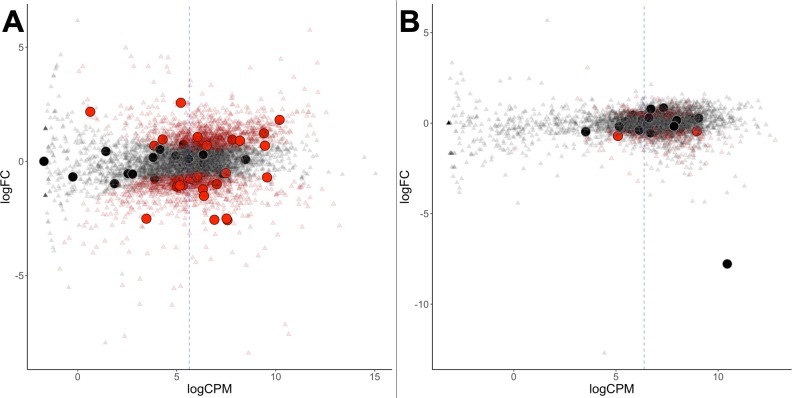
Differential gene expression of G. sulphuraria 074W.(A) and C. merolae 10D (B), here measured as log fold change (logFC) vs transcription rate (logCPM). Differentially expressed genes are colored red (quasi-likelihood (QL) F-test, Benjamini-Hochberg, p <= 0.01). HGT candidates are shown as large circles. The blue dashes indicate the average logCPM of the dataset. Although HGT candidates are not significantly more or less expressed than native genes, they react significantly stronger to temperature changes in G. sulphuraria 074W (‘more red than black dots'). This is not the case in high CO2 treated C. merolae 10D.